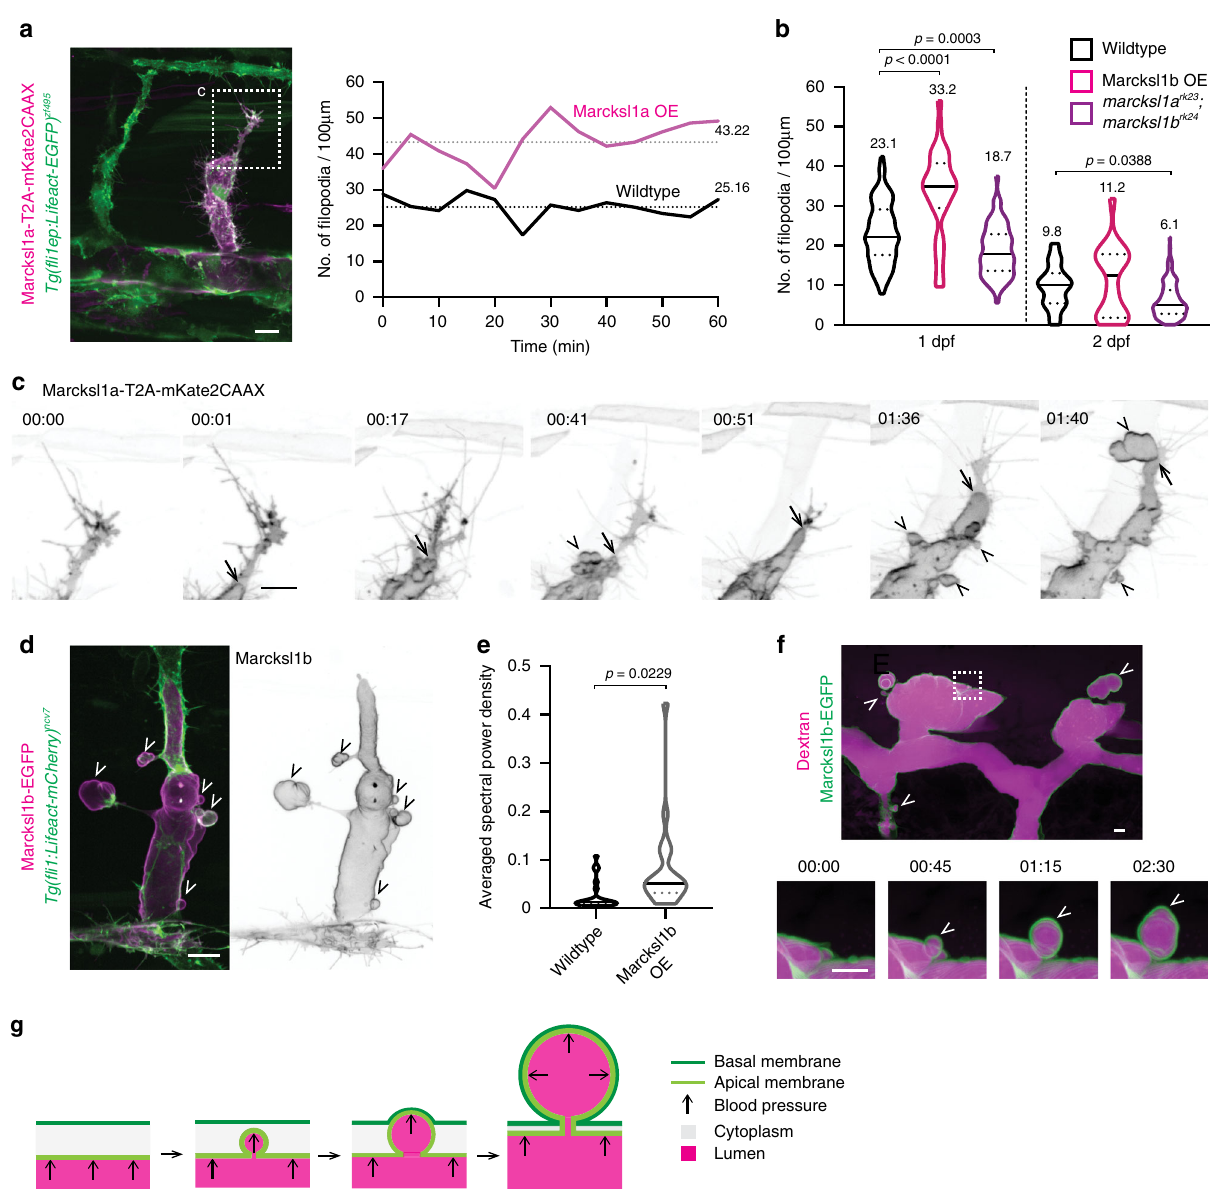
Fig. 5 Marckls1 regulates endothelial membrane behaviour during ISV formation. a , b Marcksl1 regulates fi lopodia formation. Increased expression of Marcksl1a in ECs (magenta) increases fi lopodia formation when compared to wildtype EC (green) at 31 hpf ( a ). Dashed box, region of vessel measured. Quanti fi cation of wildtype EC or ECs overexpressing Marcksl1b (Marcksl1b OE) or depleted of marcksl1a and marcksl1b at 1 and 2 dpf ( b , 1 dpf: wildtype, n = 87 ISVs/ 29 embryos; Marcksl1b OE, n = 32 ISVs/19 embryos; marcksl1a rk23 ;marcksl1b rk24 , n = 67 ISVs/16 embryos. 2 dpf: wildtype, n = 29 ISVs/10 embryos; Marcksl1b OE, n = 18 ISVs/15 embryos; marcksl1a rk23 ;marcksl1b rk24 , n = 126 ISVs/28 embryos). Statistical signi fi cance was assessed by ordinary one-way ANOVA with Sidak ’ s multiple comparisons test. Mean values are indicated. c Overexpression of Marcksl1a in ECs causes ectopic membrane blebbing during lumen expansion. Apical membrane (arrow) of an endothelial tip cell expands until the leading edge of the tip cell, at which point ectopic basal blebs (arrowhead) protrude into the surrounding tissue. Movies were taken from 31 hpf. d Overexpressing of Marcksl1b in EC (magenta) induces ectopic basal blebs (arrowhead) in the ISV of 54 hpf embryo. e Quanti fi cation of membrane blebbing shows a signi fi cant increase in blebbing in ECs with increased expression of Marcksl1b when compared to wildtype EC of ISVs in 2 dpf Tg(kdr-l:ras-mCherry) s916 embryos (wildtype, n = 21 cells; Marcksl1b OE, n = 20 cells). Statistical signi fi cance was assessed by two-tailed unpaired t test with Welch ’ s correction. f , g Marcksl1-induced blebs are comprised of apical and basal membranes (green). Newly formed basal blebs (arrowhead) are fi lled with Dextran (magenta). 00:00; minutes:seconds. Dashed box in f , a magni fi ed region. Violin plots in b , e represent the entire range of values, dotted lines indicate fi rst and third quartiles, center lines are median. Scale bars, 5 µ m ( f ) and 10 µ m ( a , c , d ). Source data are provided as a Source data fi the generation of linear actin bundles in the cell cortex. The increase in the formation of linear actin bundles may con- comitantly reorganize the surrounding actin network and create regions with sparse actin within the cortex that may be balance of branched and linear actin structures to decrease cor- susceptible to deformations (Fig. 8j). tical integrity so that membrane blebs form as a result of pressure